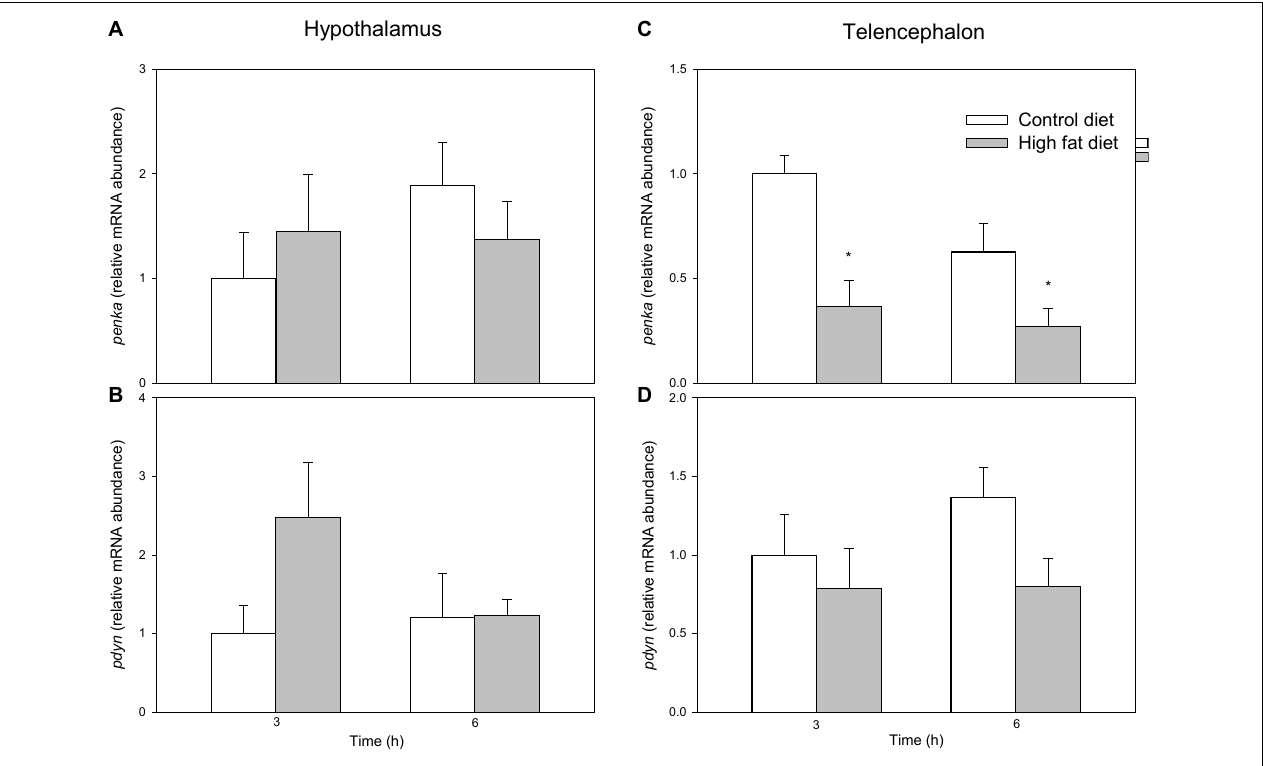
FIGURE 5 | mRNA abundance of penka (A,C) , and pdyn (B,D) in hypothalamus (A,B) and telencephalon (C,D) off of rainbow trout fed with control diet (CD) or high-fat diet (HFD) sampled at different postfeeding times (3 and 6 h). Each value is the mean + S.E.M. of 6 fish. *Significantly different ( P < 0.05) from fish fed with CD at the same